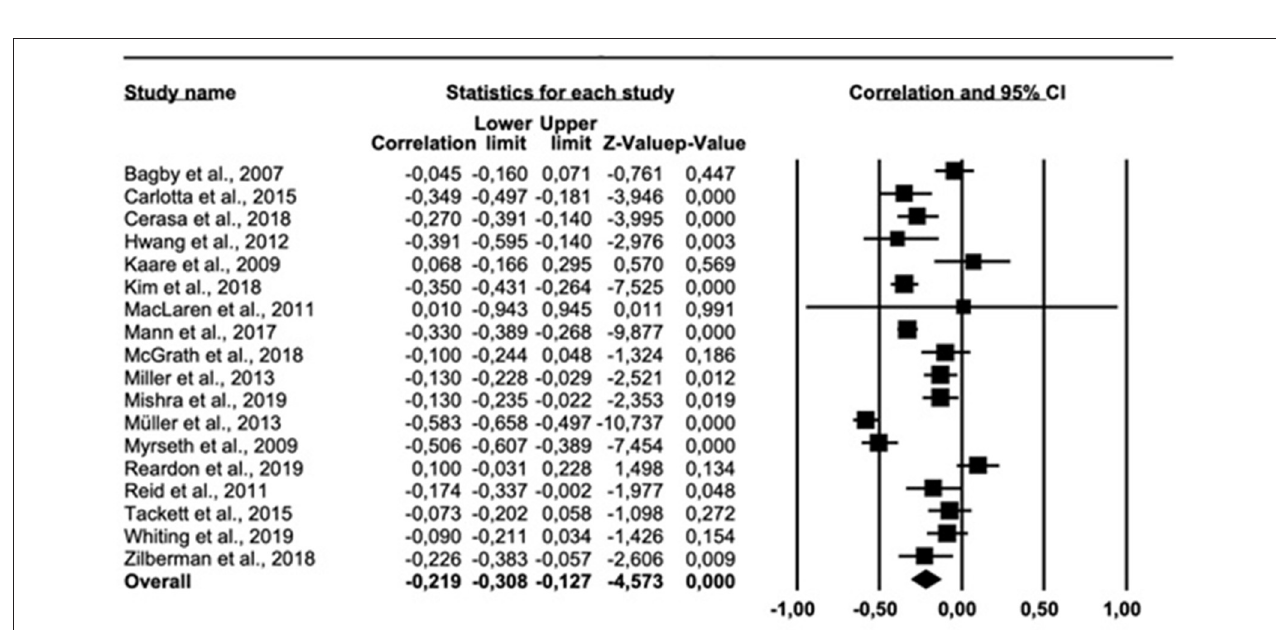
FIGURE 5 | Forest plot showing the relationship between gambling problems and openness to experience.